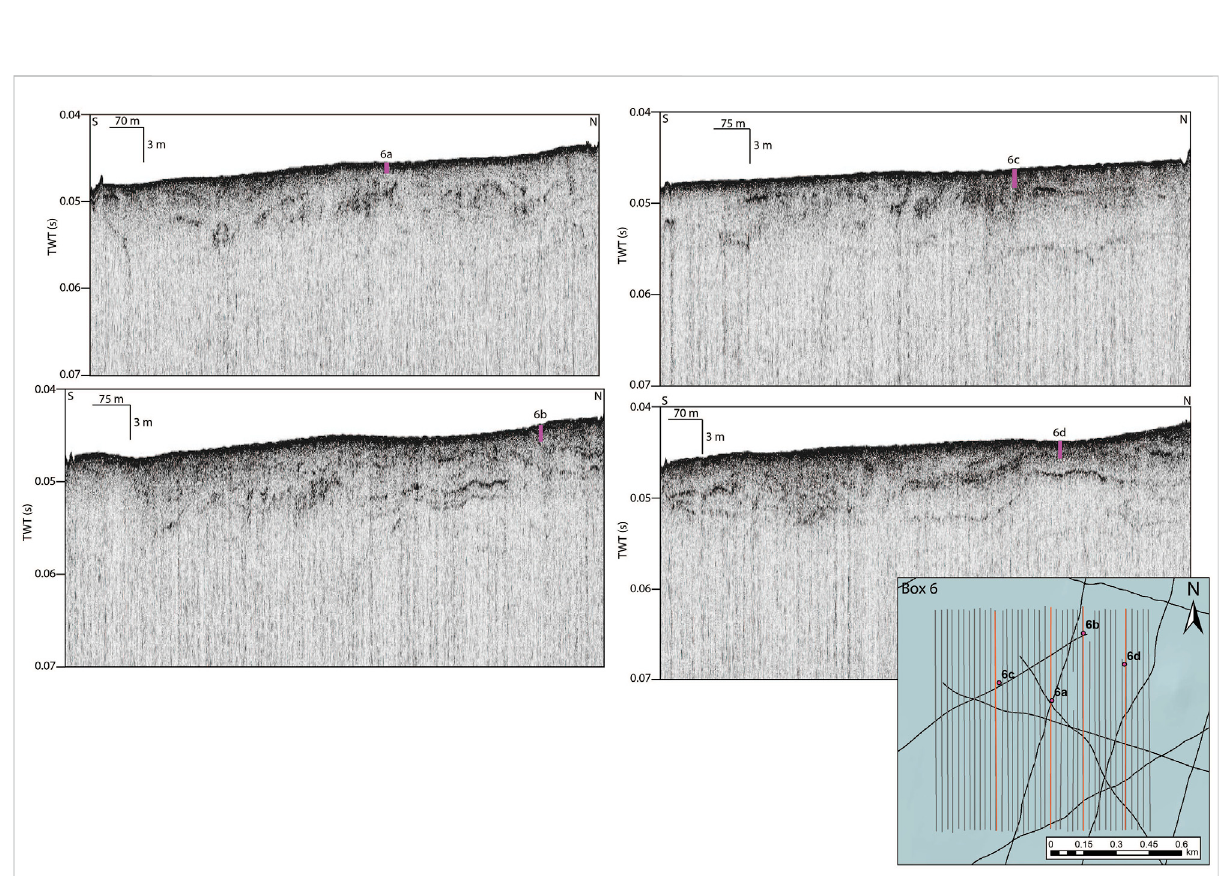
FIGURE 4 Chirppro fi leswithinBox6showinglocationsofcores.Corelocationsanddepthpenetratedintothesea fl oorshownaspinkbarsoverlainonthe Chirp pro fi les. Insetboxshows position ofthecores within Box6,and thecorresponding Chirp pro fi lesinorange. High-resolution Chirp datashown at 1 km scale to provide context for the depositional environment shown by the re fl ectors